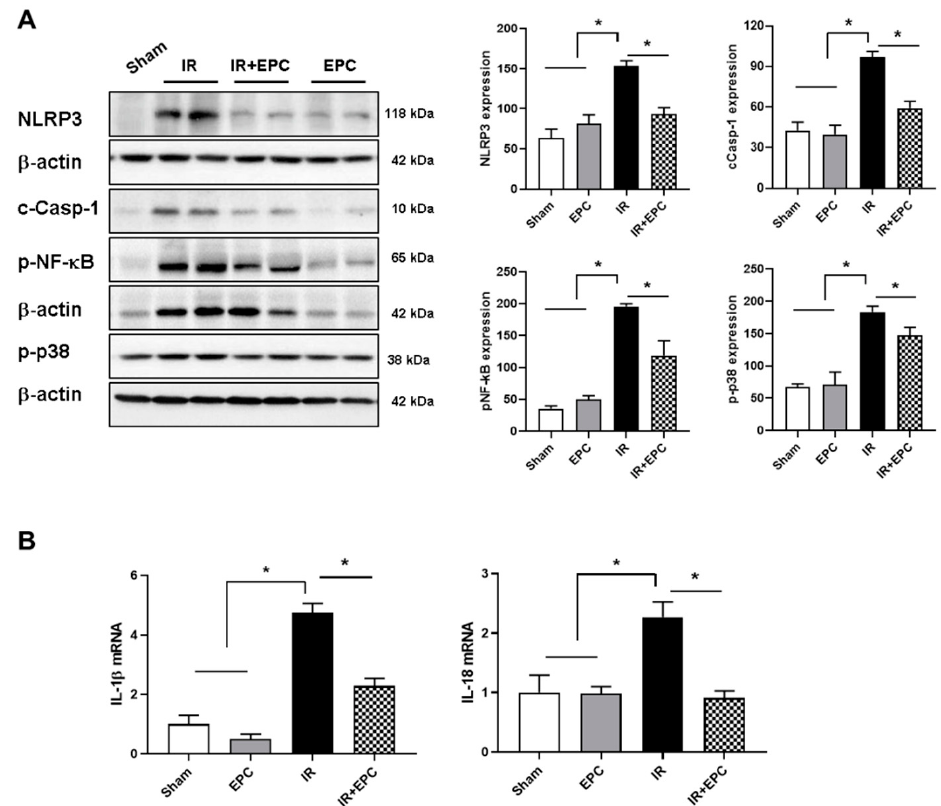
Figure 5. Effects of EPCs on the expression patterns of IRI-induced inflammasomes. A renal extract